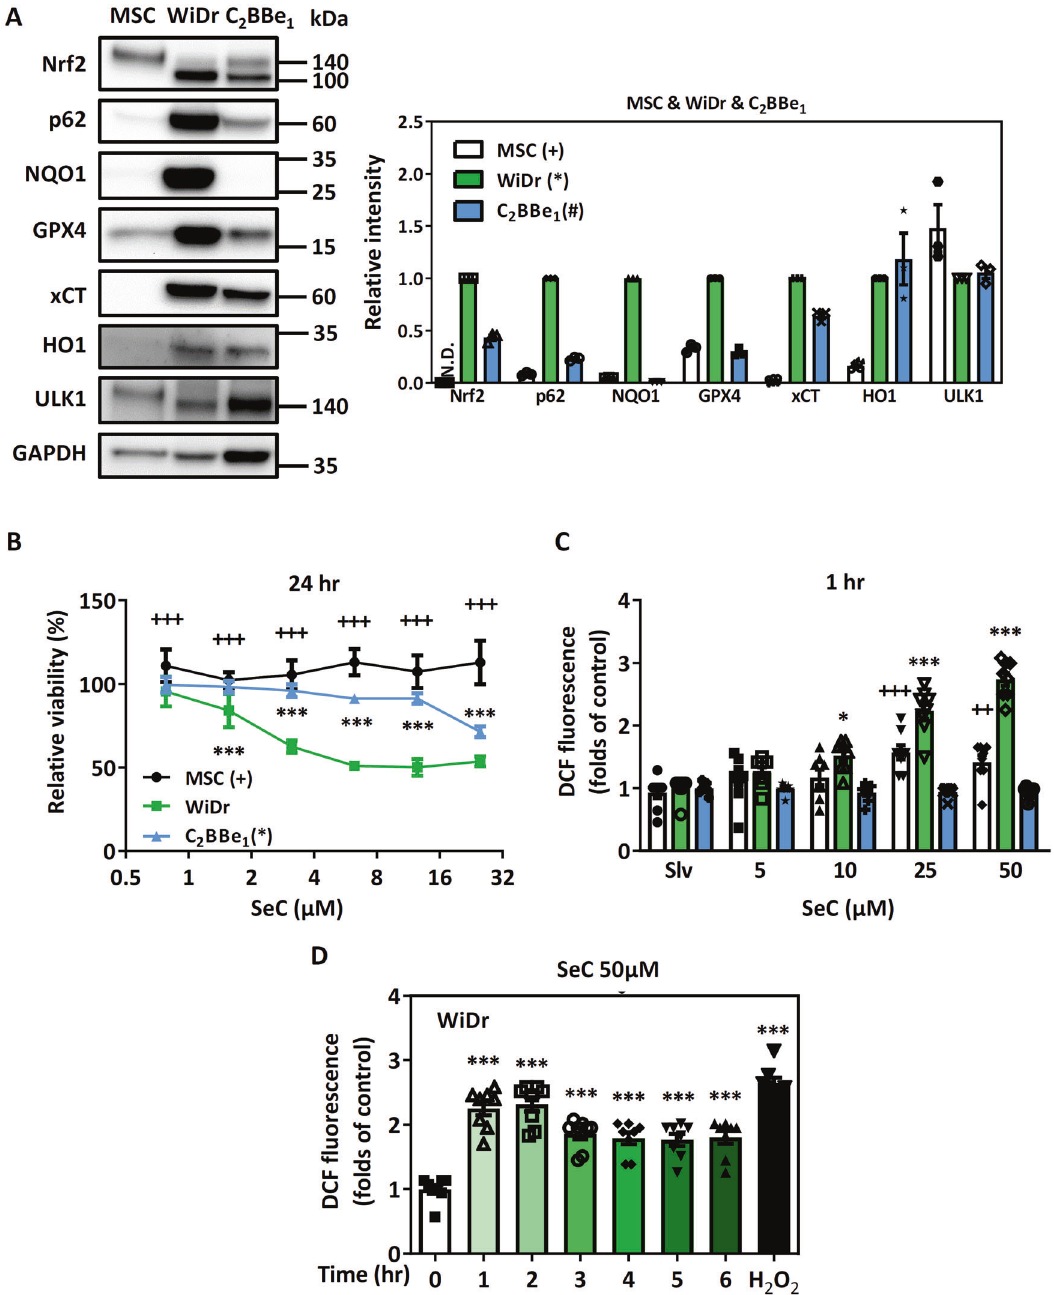
Fig. 1 Cytotoxicity and oxidative stress induced by SeC in Nrf2-addicted and non – Nrf2-addicted cells. A Comparison of Nrf2-regulated protein levels among WiDr and C 2 BBe 1 cells and MSCs. GAPDH was used as loading control ( n = 3). The values were presented as average ± SD from three independent repeats. B Cytotoxicity of SeC in WiDr and C 2 BBe 1 cells and MSCs after 24 h of treatment ( n = 8). (* and + P < 0.05, ** and ++ P < 0.01 , *** and +++ P < 0.001, compared with same concentration of SeC in WiDr cells). C ROS levels after SeC treatment in WiDr and C 2 BBe 1 cells and MSCs. D Time course of ROS production in WiDr cells after SeC treatment ( n = 8). All quanti fi ed results of cytotoxicity and ROS were express as mean ± SD from eight independent repeats. (* and + P < 0.05, ** and ++ P < 0.01, *** and +++ P < 0.001, n = 8, compared with the solvent control group). Signi fi cance was determined by an unpaired t